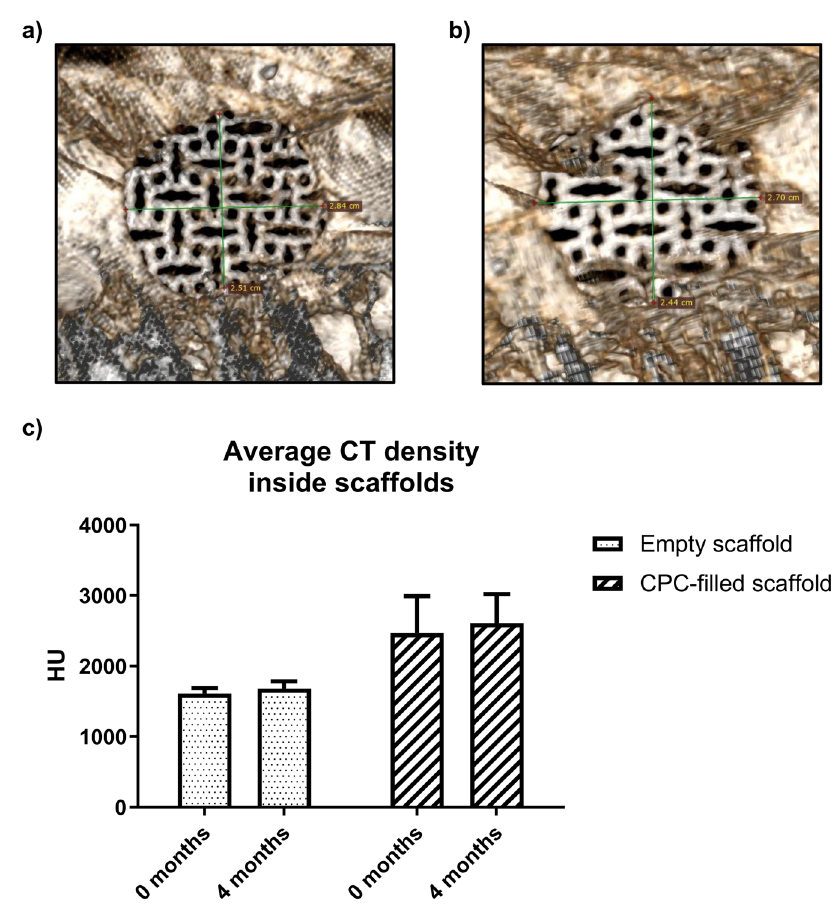
Fig. 4 CT scans of the defect of the control group con fi rming the successful creation of a critical size defect [( a ): direct postoperatively; ( b ): CT after euthanization]. c Results of the average CT density measured at fi ve points inside the scaffolds. Values between the different points in time do not differ signi fi cantly. Higher denitites of the CPC- fi lled group are caused by the CPC